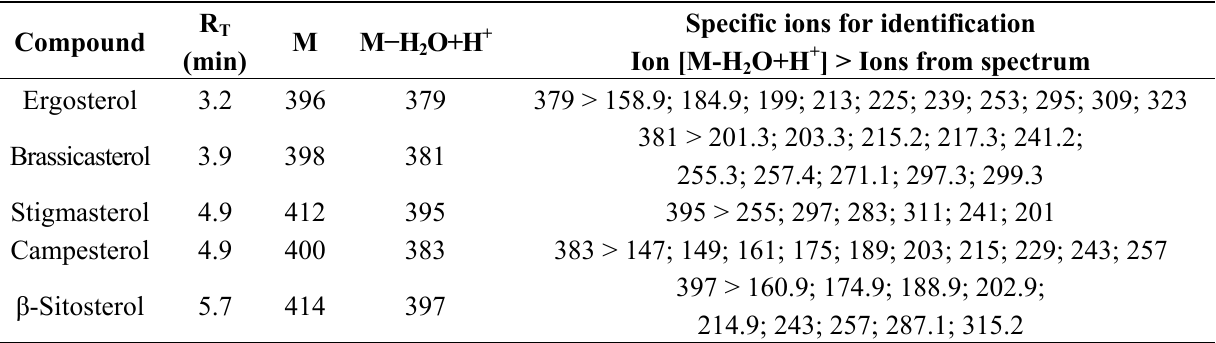
Table 3. Characteristic ions of standard sterols in full scan and specific ions used in quantification.